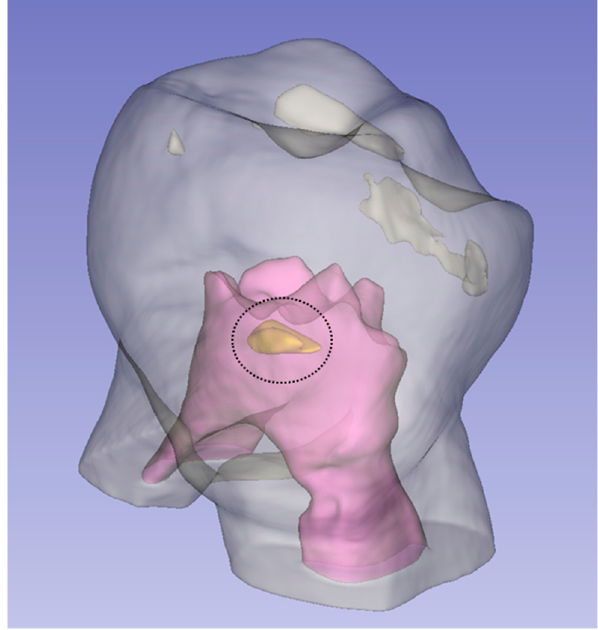
Figure 12. The circumference encloses the three-dimensional hyperdense image reconstruction in 1MI (pulp stone in yellow).